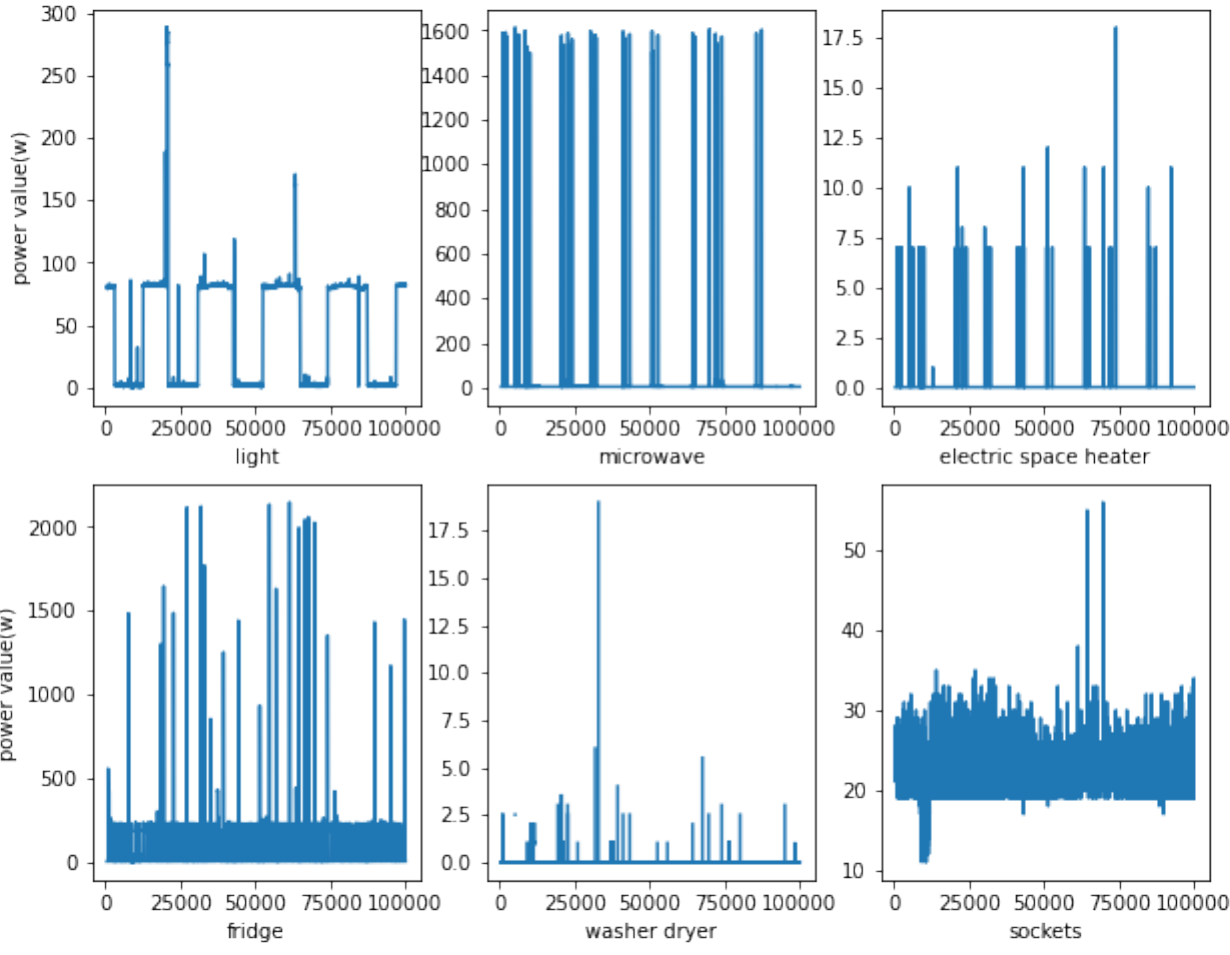
Figure 2. Appliance period characteristics in REDD